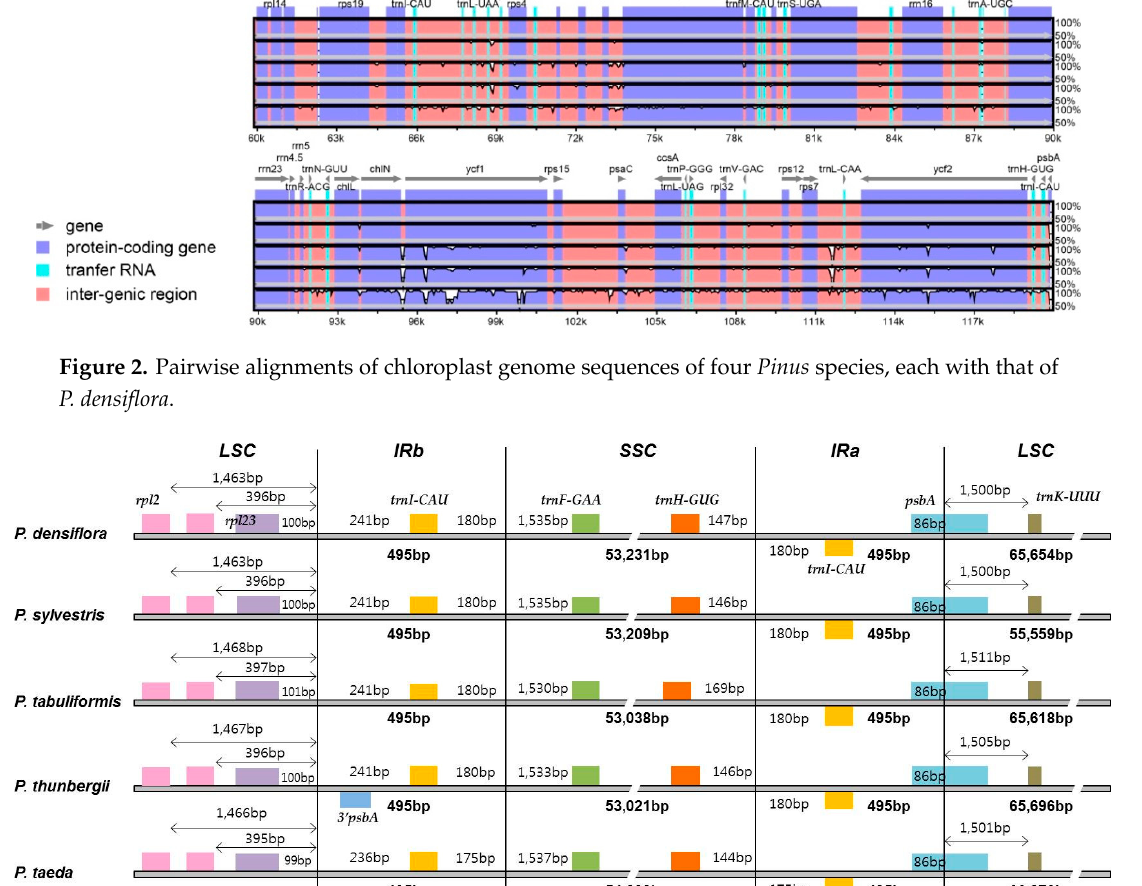
Figure 2. Pairwise alignments of chloroplast genome sequences of four Pinus species, each with that of P. densiflora .